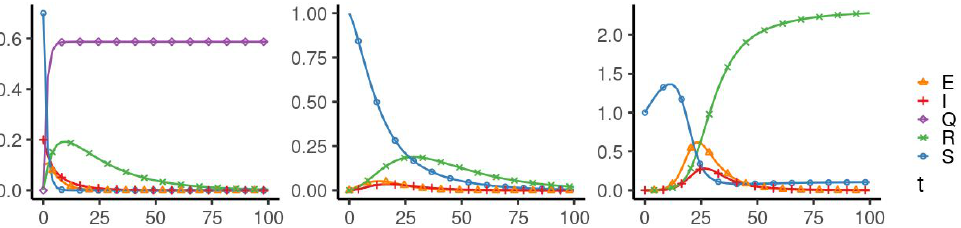
Figure 17. Experiment 3. Spread of the virus in the controlled case (responsible individuals). ( Left ): 1 level, ( middle ): 2 level, ( right ): 3 level.